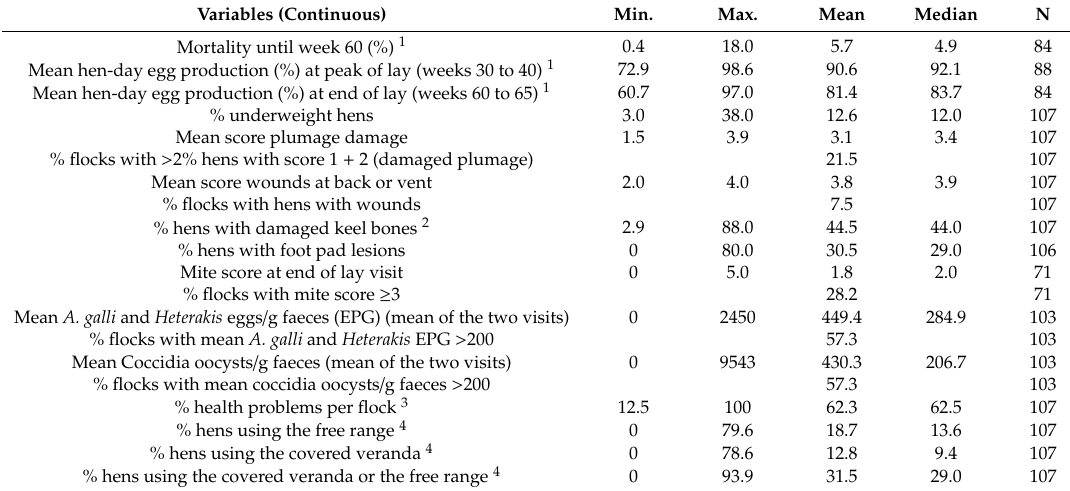
Table 5. Range (minimum, maximum), means and medians for the production data and health outcomes around the peak and around the end of lay from organic laying hen flocks in eight European countries. Variables (Continuous) Min.